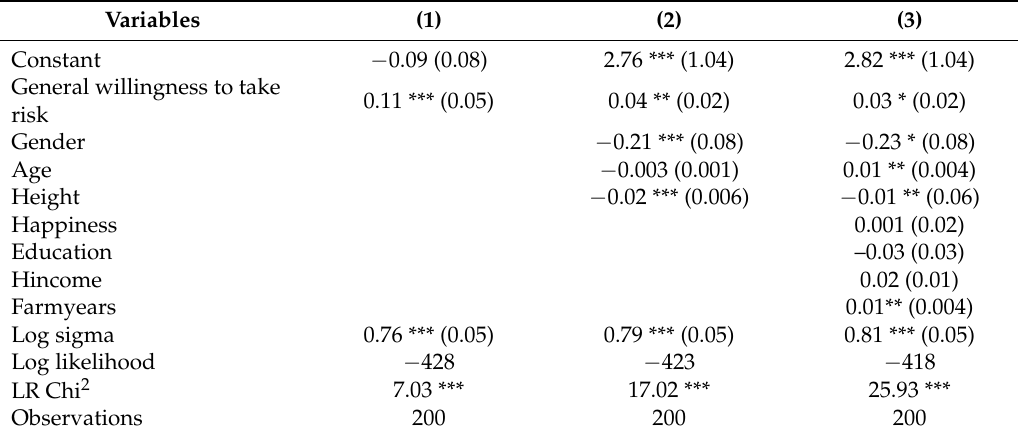
Table 7. Multivariate correlates of the experiment and survey